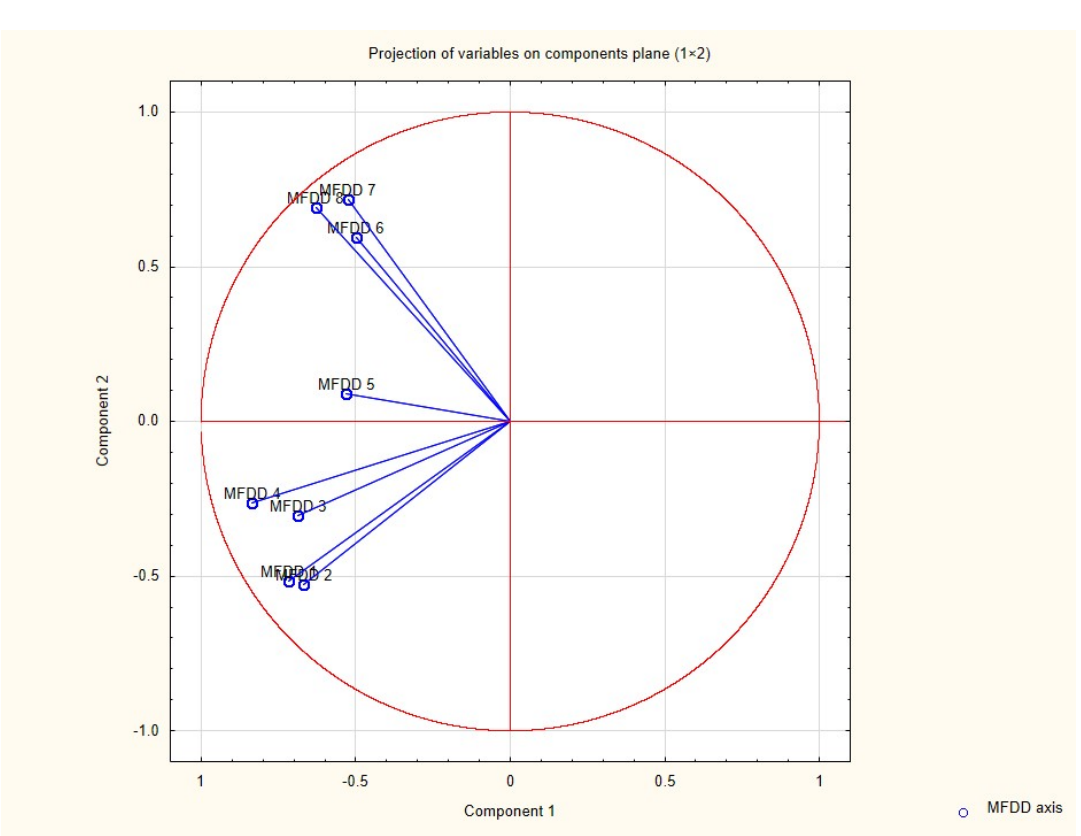
Figure 1. Scree plot. Each point is described by the percentage of the total variance explained by that component.